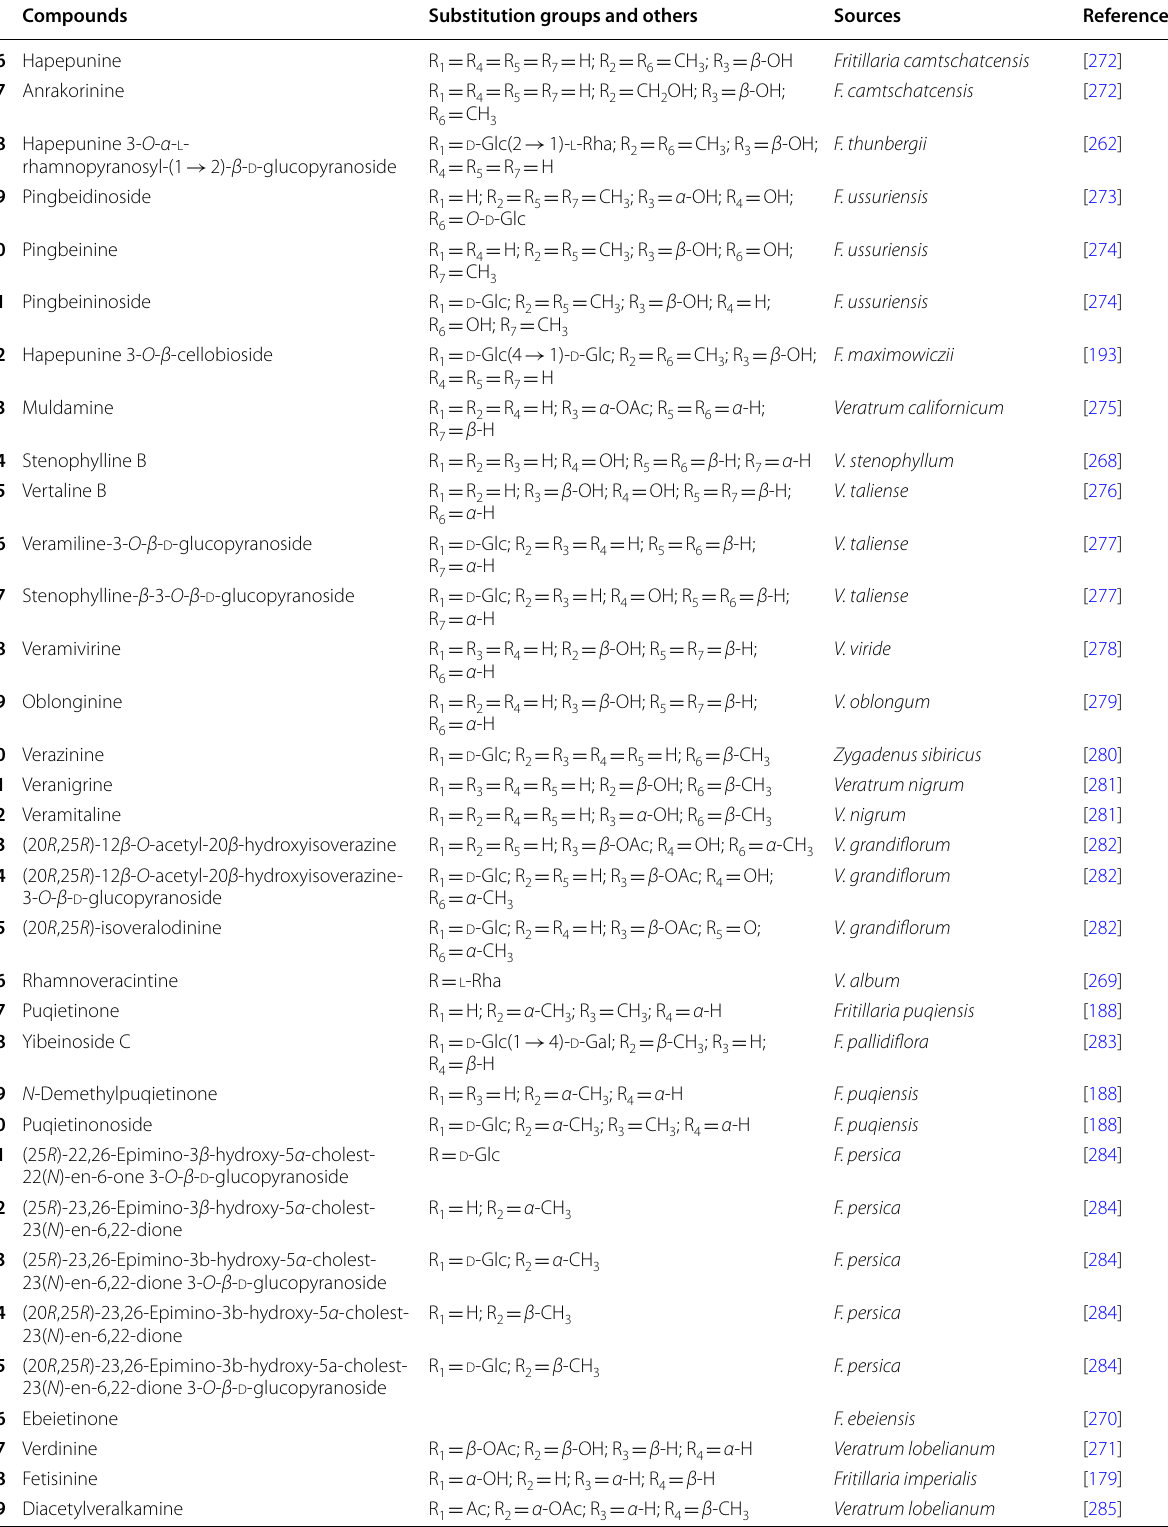
Table 11 Structures and sources of verazine type steroidal alkaloids 556–601 No